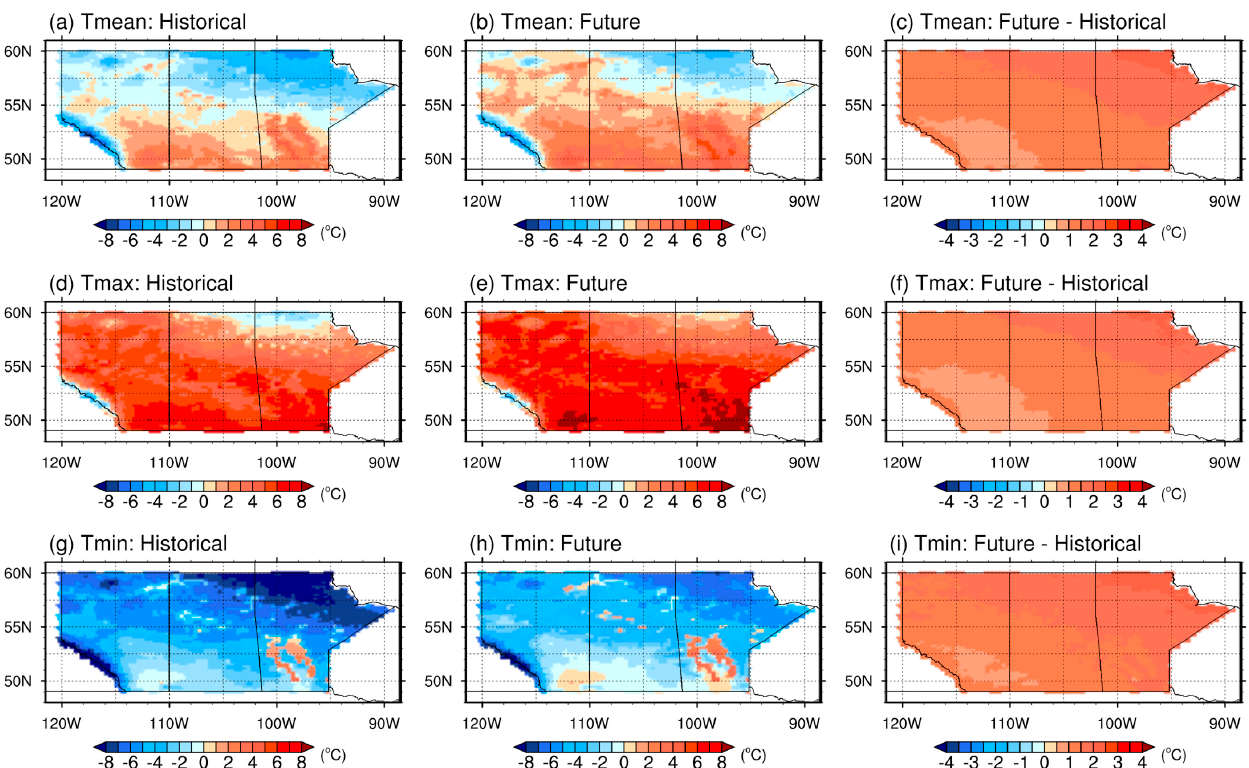
Figure 3. Projected variations of annual averages of T mean , T max , and T min for the period of 2036 to 2065 under RCP45. ( a , d , g ) show the historical distributions of T mean , T max , and T min , respectively; ( b , e , h ) show the future distributions of T mean , T max , and T min , respectively; ( c , f , i ) show the projected variations of V mean , V max , and V min , respectively.